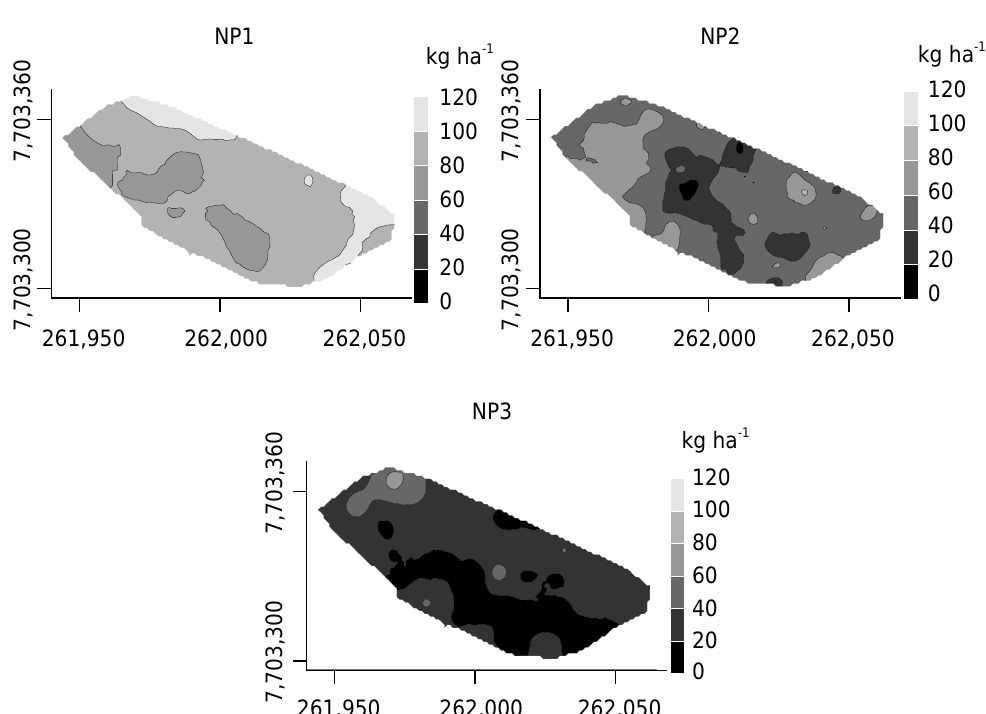
Figure 3. Spatial distribution of phosphorus needs in the three studied